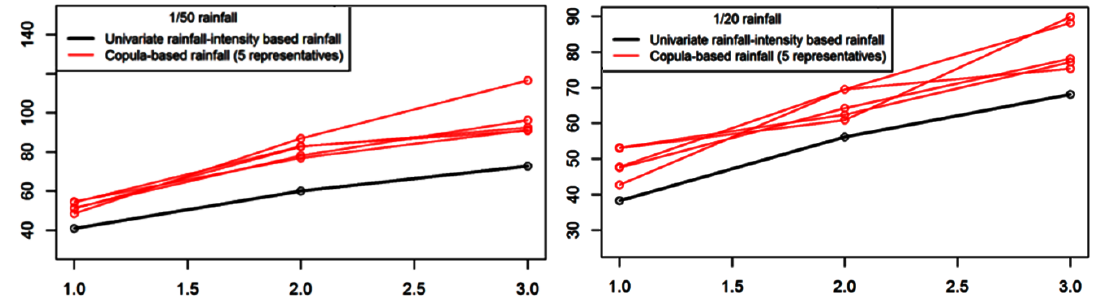
Figure 12. Comparison of 1-h, 2-h, and 3-h rainfall calculated using the copula-based design rainfalls and the IDF-curve-based ones for 1/50 and 1/20 events.